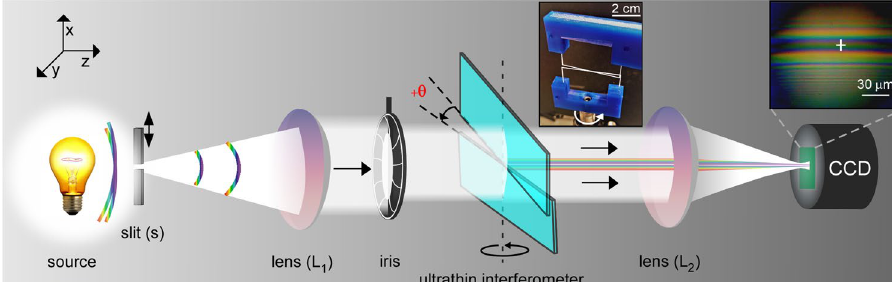
Figure 1. A schematic diagram of ultrathin white light interferometer. A broadband light source is made to pass through a variable slit (s) and collimated using a lens ( L 1 ) and the interference fringes are collected on a chip with a convex lens ( L 2 ). Insets: Pictures of the interferometer and a typical interference fringes.